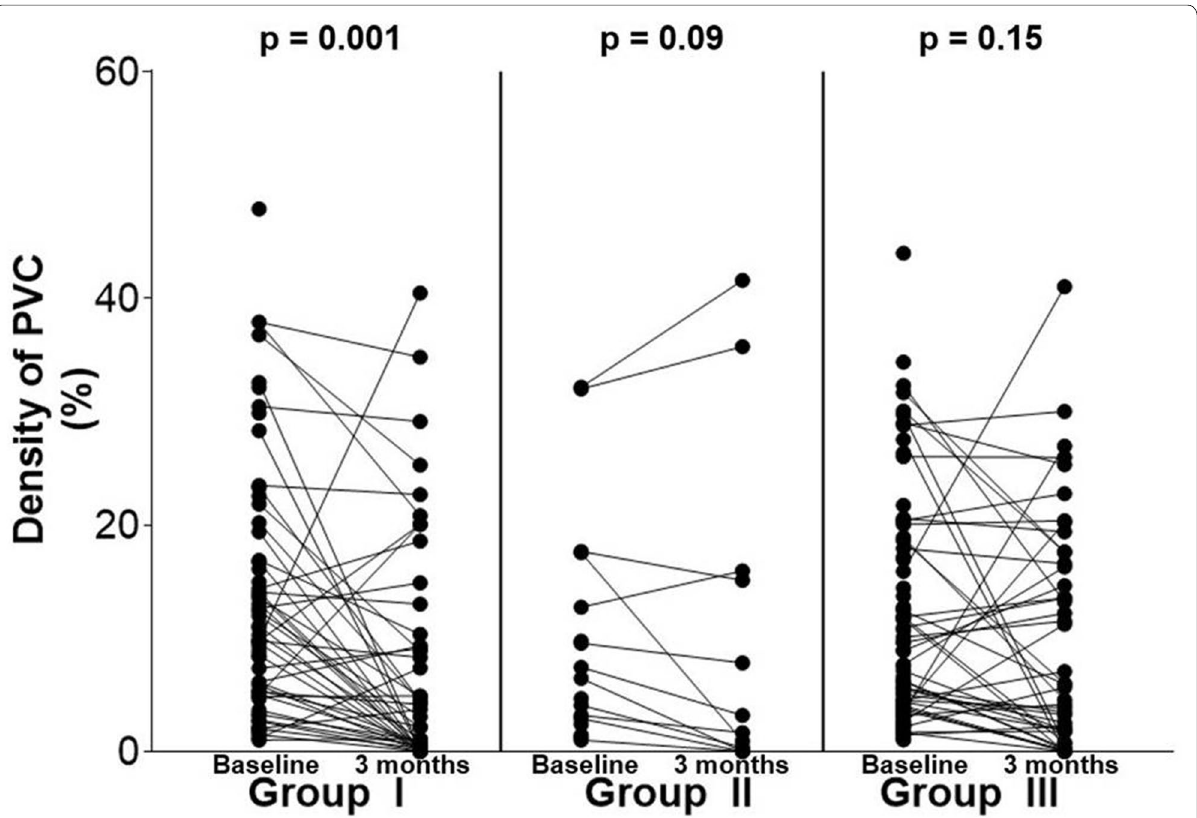
Fig. 4 Changes in the density of PVC after β‑blocker treatment according to groups. The density of the PVC was significantly reduced only in patients of Group I and there were no significant differences in those of Group II and Group III. PVC